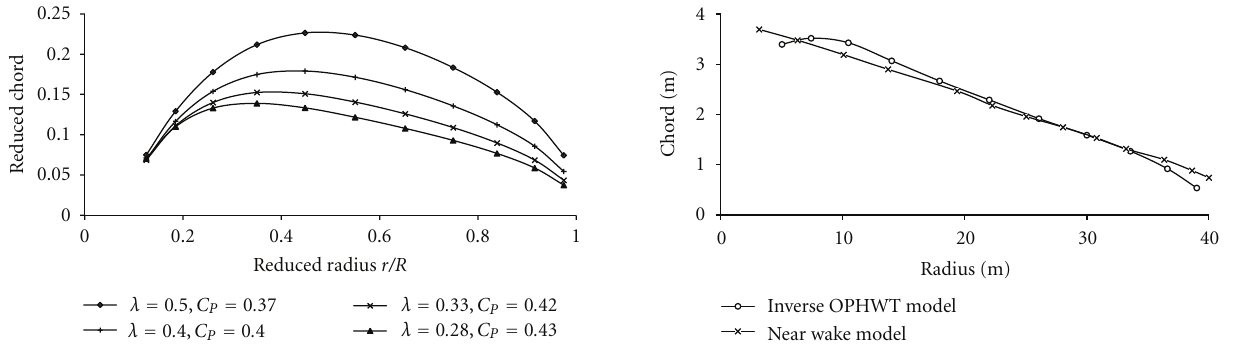
Figure 8: Spanwise variation of the chord in the inverse OPHWT model and the Near wake model for N b = 3 and α = 8 ◦